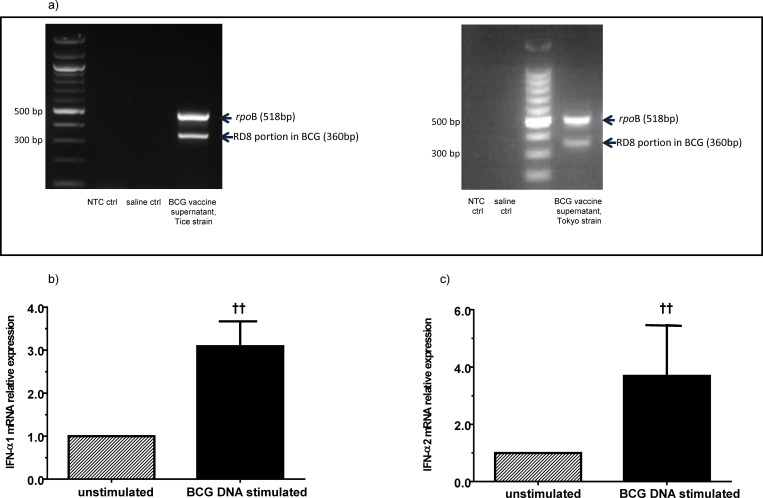
The Bacille Calmette Guérin (BCG) vaccine contains extracellular mycobacterial (BCG) DNA which induces Type I interferon (IFN) production in human neonatal plasmacytoid dendritic cells (pDCs).(a) The cell-free supernatants of reconstituted BCG vaccine vials from two different manufacturers contain BCG DNA. PCR for 2 mycobacterial (BCG-specific) genes on the cell-free supernatants was performed as described in the Methods section, and the PCR products were run on an agarose gel and stained with ethidium bromide. Isolated human umbilical cord blood pDCs were stimulated with BCG DNA (100 μg/ml) for 8 hours and the relative expression levels of (b) IFN-α1 mRNA and (c) IFN-α2 mRNA were determined by qRT-PCR. †† p = 0.07, n = 3 independent experiments, bars are median values and error bars are S.D.